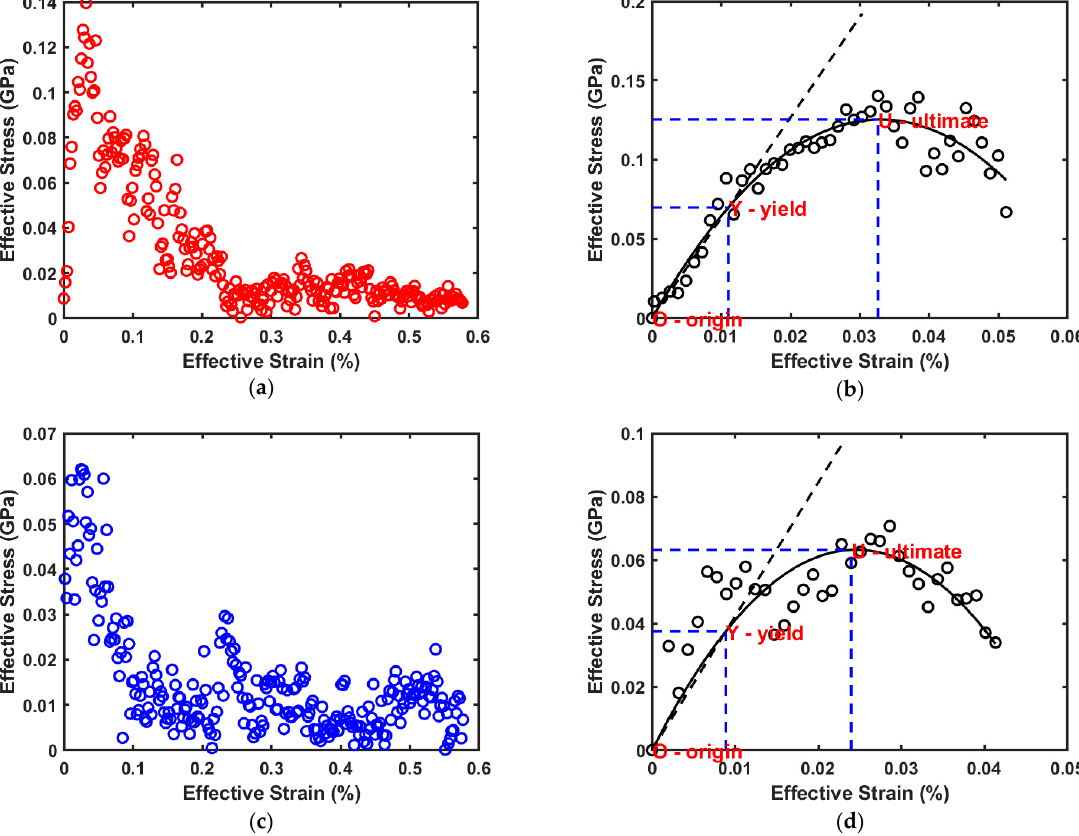
Figure 2. ( a ) Effective strain vs. effective stress data for cellulose. ( b ) Stress–strain model fit for cellulose. ( c ) Effective strain vs. effective stress data for adulose. ( d ) Stress–strain model fit for adulose. Table 1. Mechanical properties of cellulose and adulose.